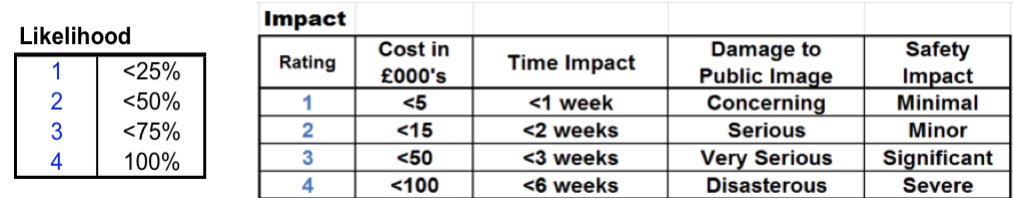
Figure 4. Generic risk model (NIST SP 800-82r2, 2015).